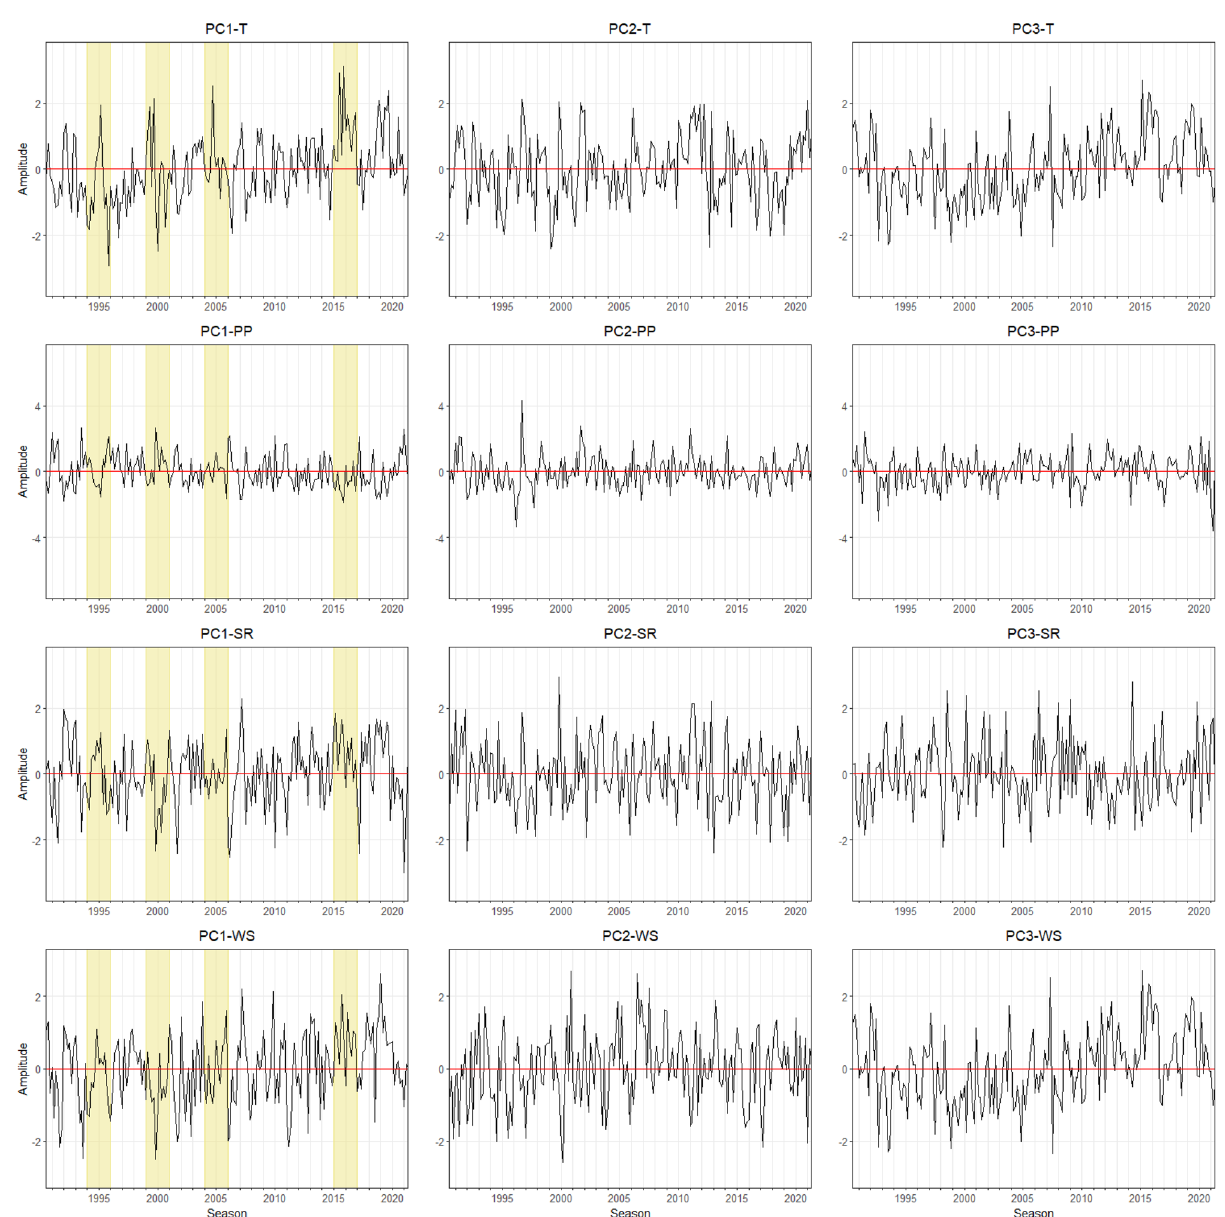
Figure 3. Monthly time series of growing season patterns (Principal components, PC) corresponding to EOF-1, EOF-2, and EOF-3 for the Free State province (see Fig. 2). Strong positive or negative anomalies of the dominant mode are highlighted (extreme events). The x-axis ticks indicate the beginning period of growing season. The abbreviations of agrometeorological data (T, PP, SR, WS) refer to Table